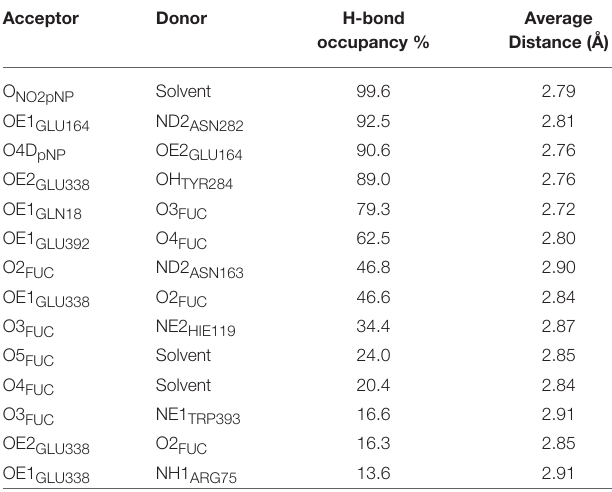
TABLE 1 | Analysis over the MD simulation of the most populated hydrogen-bonds between p NP-Fuc, protein residues, and water molecules at the active